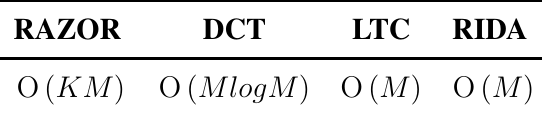
Table 1. Computational complexity. DCT, Discrete Cosine Transform; LTC, Lightweight Temporal Compression (LTC); Robust Information-Driven Data Compression Architecture (RIDA).